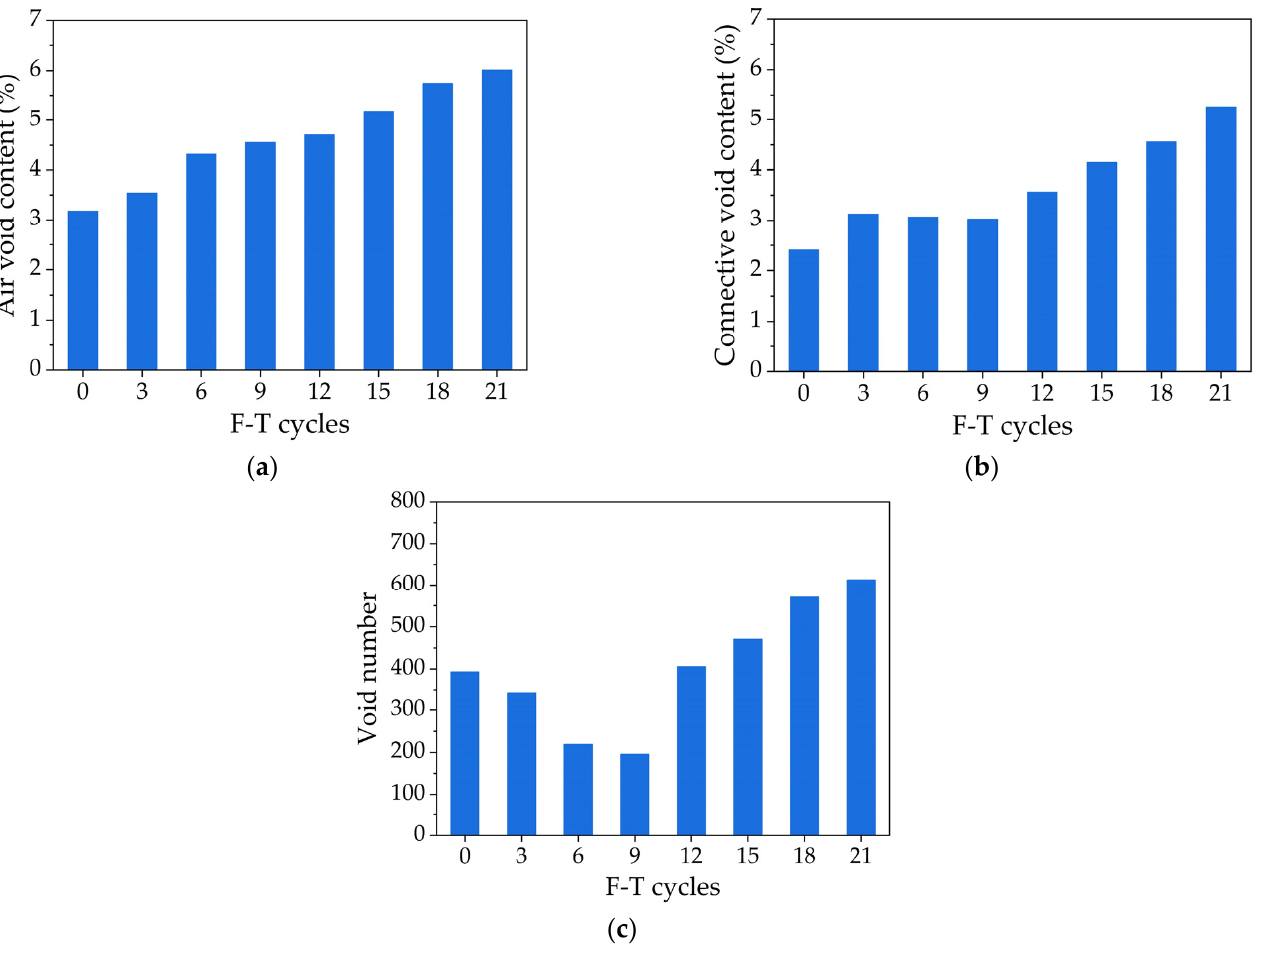
Figure 10. Distribution of internal meso-void characteristics of asphalt mixture under F-T conditions: ( a ) air void content; ( b ) connective void content; ( c ) void number.